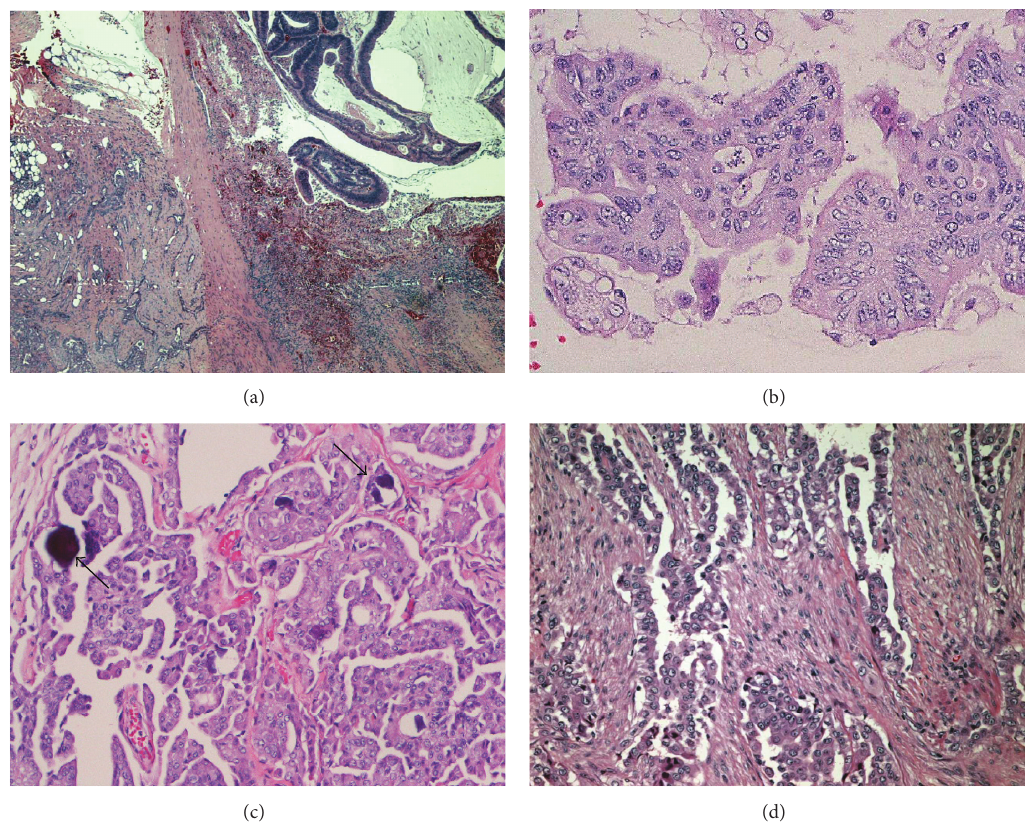
Figure 2: Histopathology of tumors. (a) Malignant mesothelioma (left) and adenocarcinoma in mucin pool (right). (b) Adenocarcinoma with atypical glands. (c)Mesothelioma showing psammoma bodies (arrows)and papilla with fibrovascular cores. (d) Mesothelioma demonstrating tubuloglandular